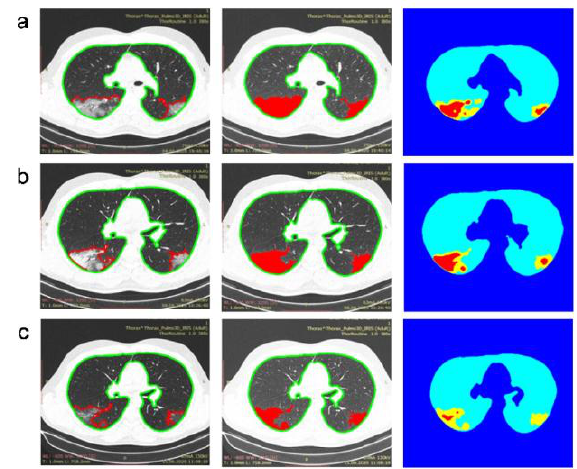
Figure 8. Examples of CT image processing of lungs with COVID-19 (1st patient): a) observation on the 3rd day of illness; b) observation on the 7th day of illness; c) observation on the 14th day of illness.